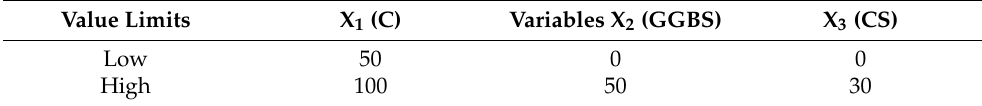
Table 5. Mixture component value